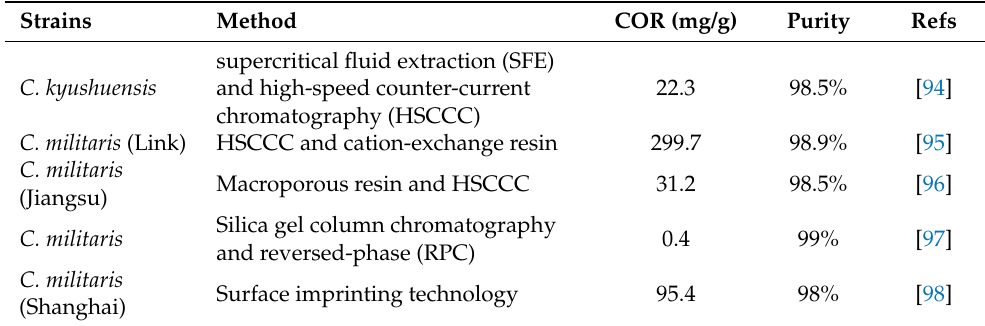
Table 6. Methods for separation and purification of